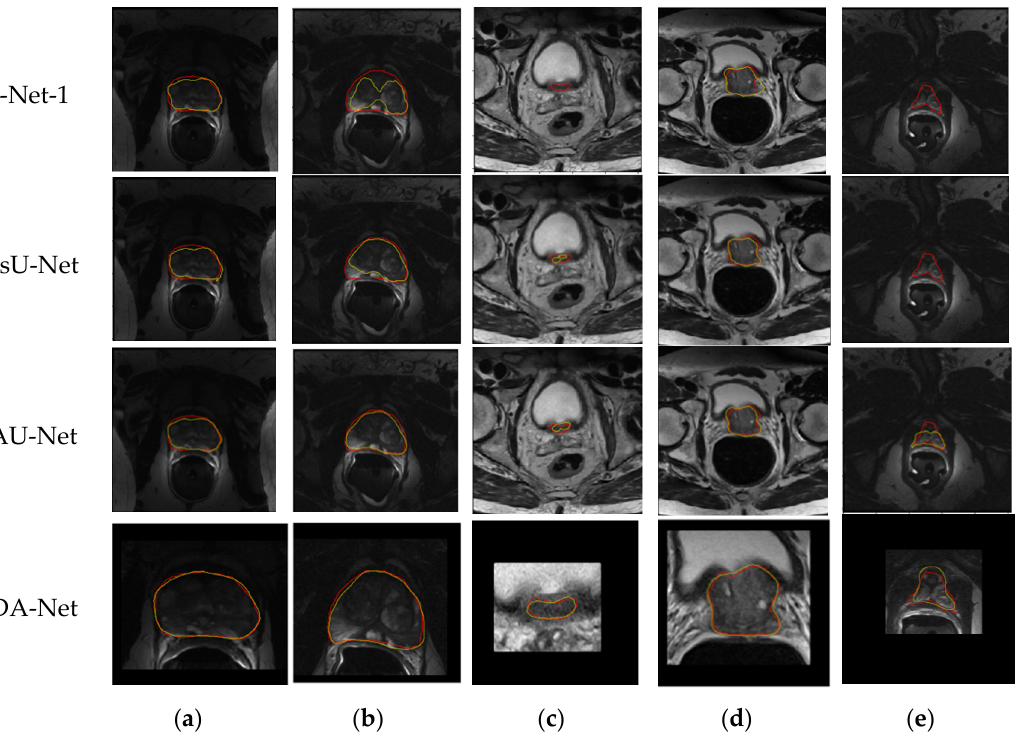
Figure 10. Qualitative comparison results of the algorithms on the test set from PROMISE12 (the red line masked the true contour of the prostate and the green line masked the contour obtained by the algorithm; ( a ) the images with ERC; ( b ) the image with an uneven gray distribution of glands; ( c ) the images at the base of sequences; ( d ) the images at the base of sequences with irregular organ shapes, ( e ) the images at the apex of